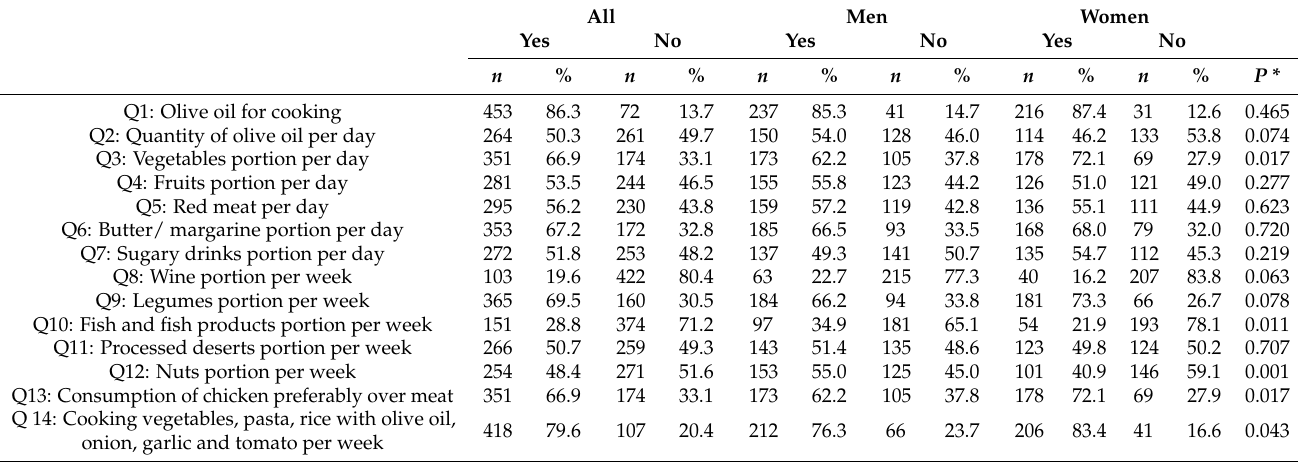
Table 2. Stratification of adherence to MedDiet